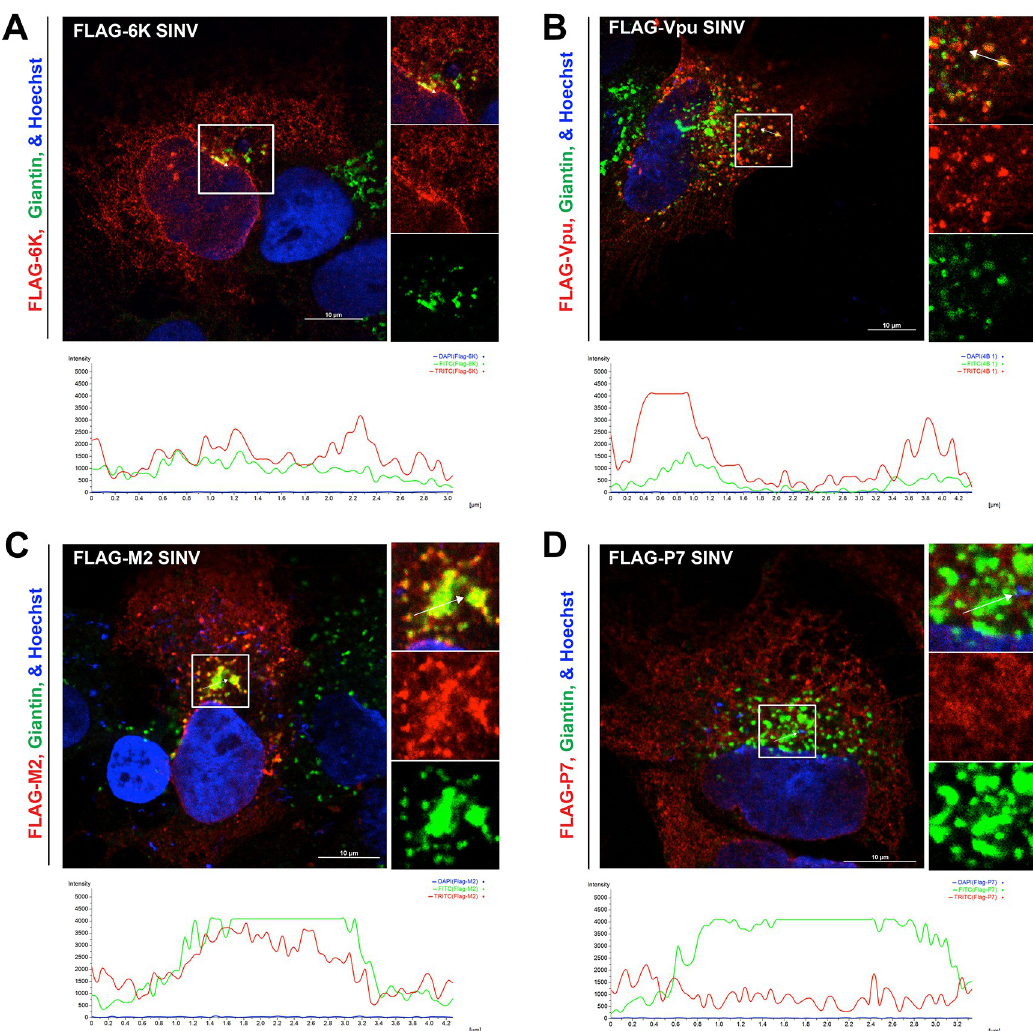
Fig 5. Localization of 6K and the ion channel chimeras. (A-D) IF analysis using anti-FLAG (red) and anti-Giantin (green) antibodies of permeabilized huh-7.5 cells infected with an MOI of 5 of (A) FLAG-6K SINV, (B) FLAG-Vpu SINV, (C) FLAG-M2 SINV, or (D) FLAG-P7 SINV. Cells were fixed at 12 hpi. Regions of interest are marked and enlarged to the right as separate channels. Fluorescent profiles of the lined areas are displayed at the bottom. Distance is in μ m and intensity is in arbitrary fluorescence units